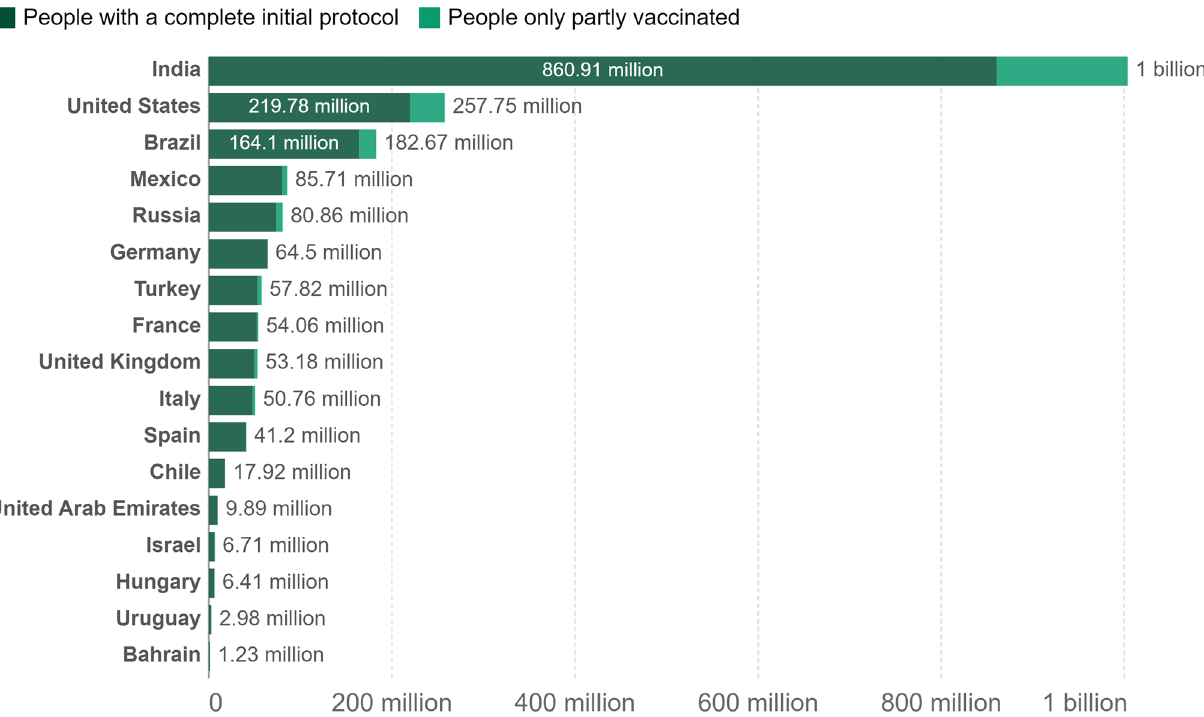
Fig. 1 Number of people vaccinated against COVID-19: Alternative definitions of full vaccination, (e.g., having been infected with SARS- CoV-2 and having one dose of a two-dose protocol) were ignored to Fig. 2 COVID-19 vaccine doses administered: For vaccines that require multiple doses, each dose is counted. As the same person may receive more than one dose, the number of doses can be higher than the number of people in the population